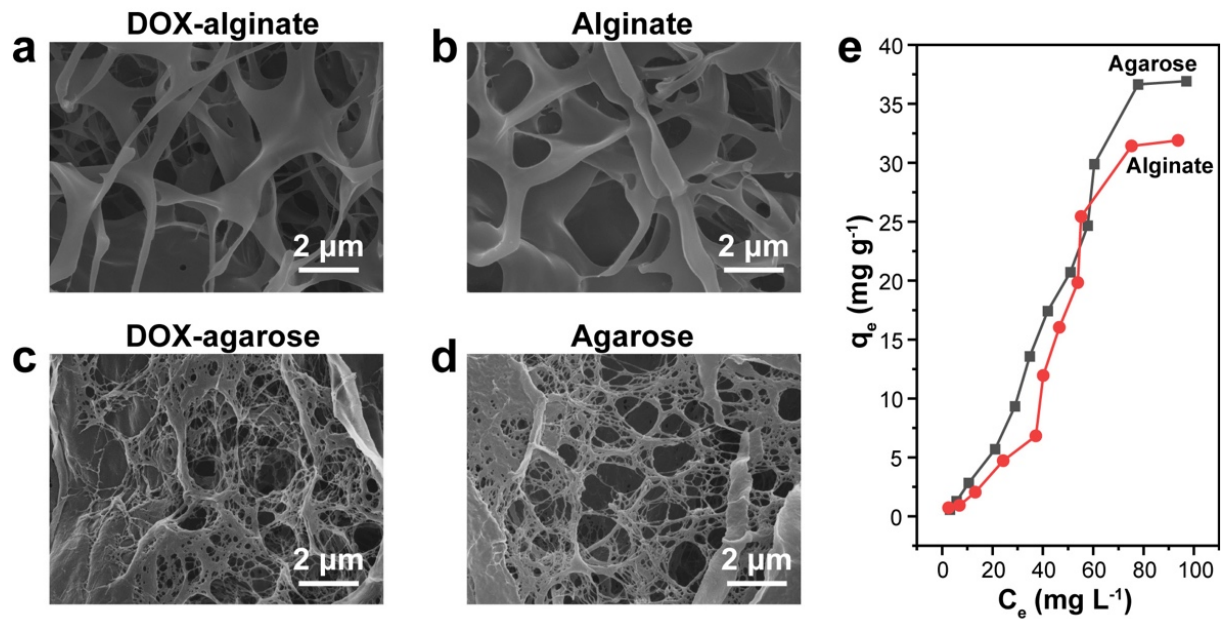
Figure 3. ( a , b ) SEM images of lyophilized DOX-alginate ( a ) and alginate ( b ) hydrogels, where the concentrations of DOX and alginate were 2 g L − 1 and 2 wt%, respectively. ( c , d ) SEM images of lyophilized DOX—agarose ( c ) and agarose ( d ) hydrogels, where the concentrations of DOX and agarose were 2 g L − 1 and 2 wt%, respectively. ( e ) Adsorption isotherms of DOX molecules with lyophilized alginate and agarose hydrogels (2 wt%).